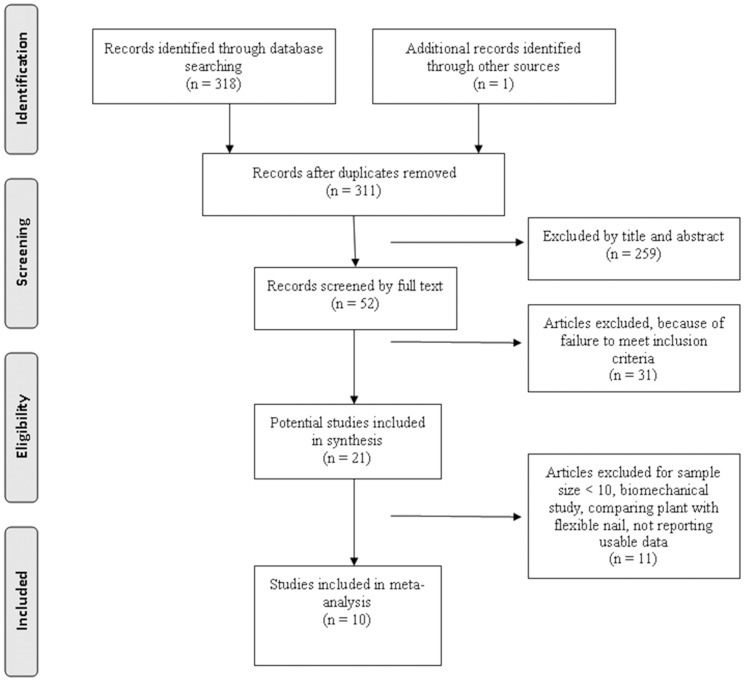
The study selection and inclusion process.